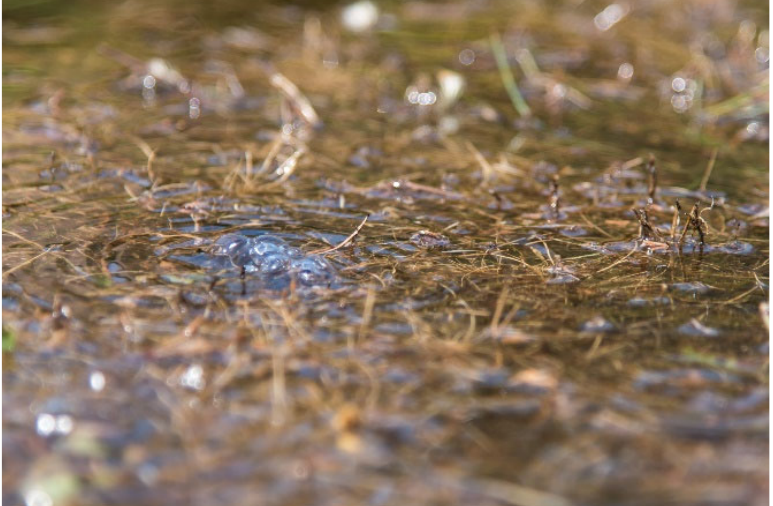
Figure 12. Significant bubbles during the filling process indicating (preferential) flow during the drought period: air-filled pores are filled with water forcing out the trapped air. The variation in initial infiltration capacity of 1.6 to 11.9 m/d of the three swales situated in the same street was received by the municipality with more surprise. However, same observations were recorded in other municipalities, such as Tilburg and Arnhem, where the same full-scale method was used on several green infrastructures on one street (Figure 13) showing a high variation in infiltration rate (Figure 14).